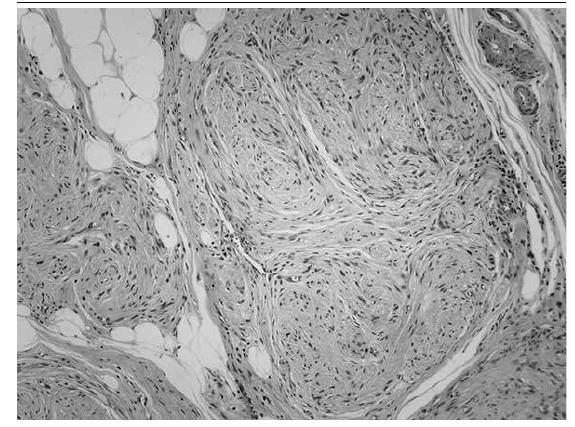
FIguRe 2 – Plexiform neurofibroma: a benign soft tissue tumor composed of cells which have oval to elongate normochromatic nuclei, expanding the nerve fascicle, HE, 200× HE: hematoxylin and eosin stain.